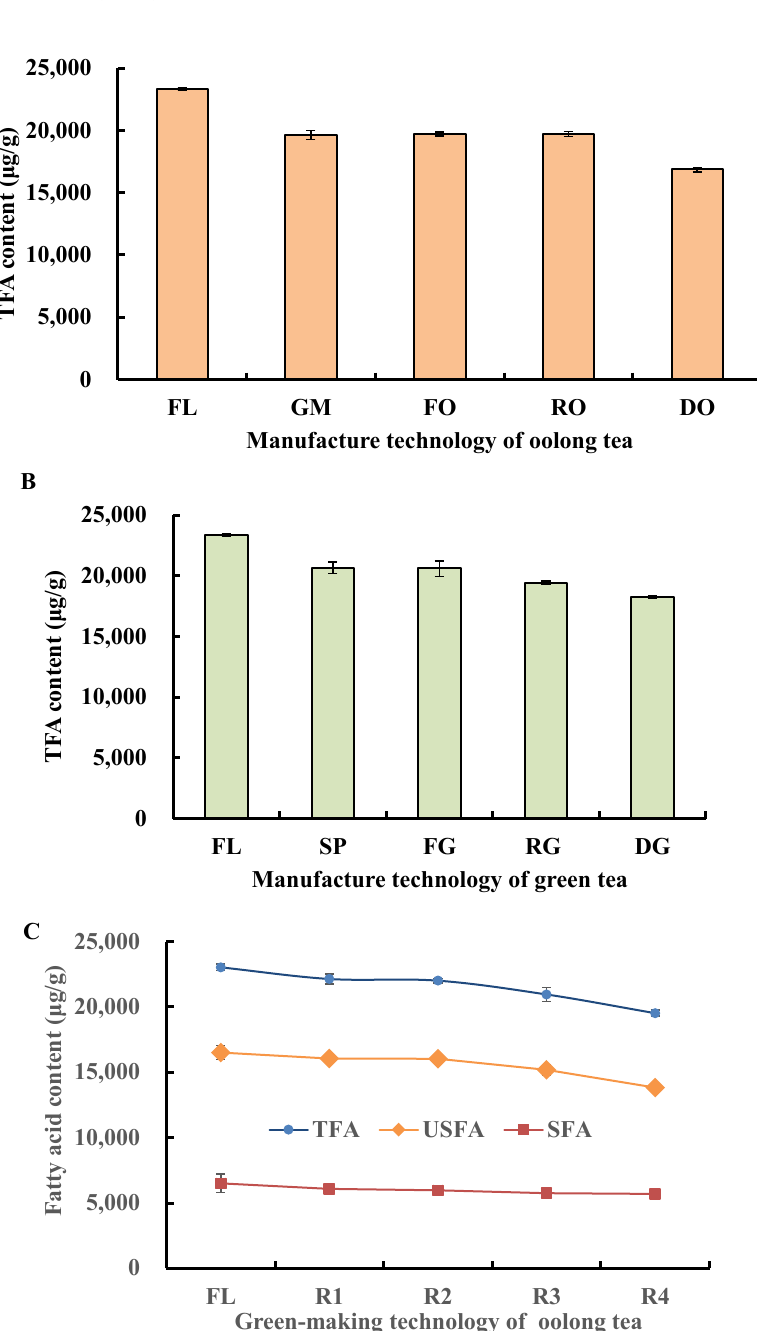
Figure 2. Fatty acids influenced by tea processing technology. ( A ) Total fatty acids changed during oolong tea processing, ( B ) total fatty acids changed during green tea processing, ( C ) different fatty acids changed during the green-making stage. TFA, USFA, and SFA indicate total fatty acids, unsaturated fatty acids, and saturated fatty acids, respectively; FL, GM, FO, RO, and DO indicate fresh leaves, green-making step, fixation of oolong tea, rolling of oolong tea, and drying of oolong tea, respectively; FL, SP, FG, RG, and DG indicate fresh leaves, spreading, fixation of green tea, rolling of green tea, and drying of green tea, respectively; and FL, R1, R2, R3, and R4 indicate fresh leaves, 1st turnover, 2nd turnover, 3rd turnover, and 4th turnover of oolong tea,